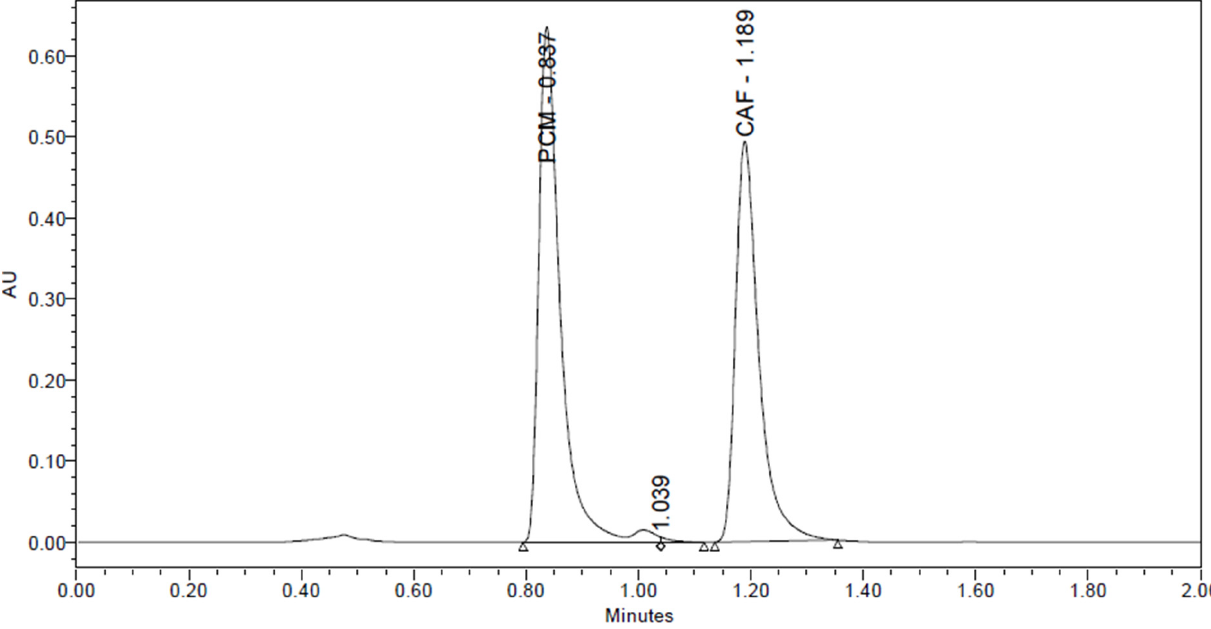
Figure 9. Chromatogram of PCM and CAF for photolytic degradation.